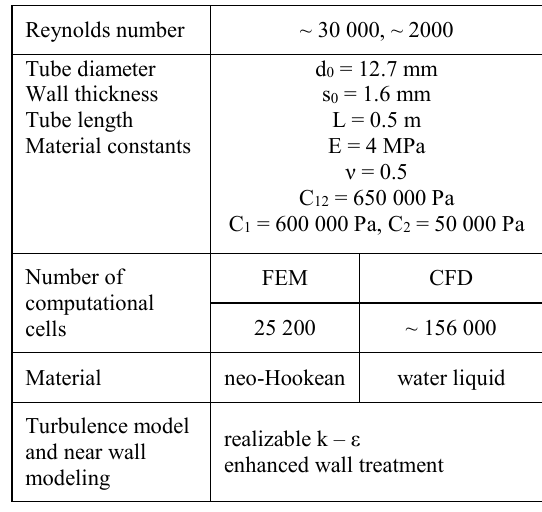
Table 1. Description of numerical